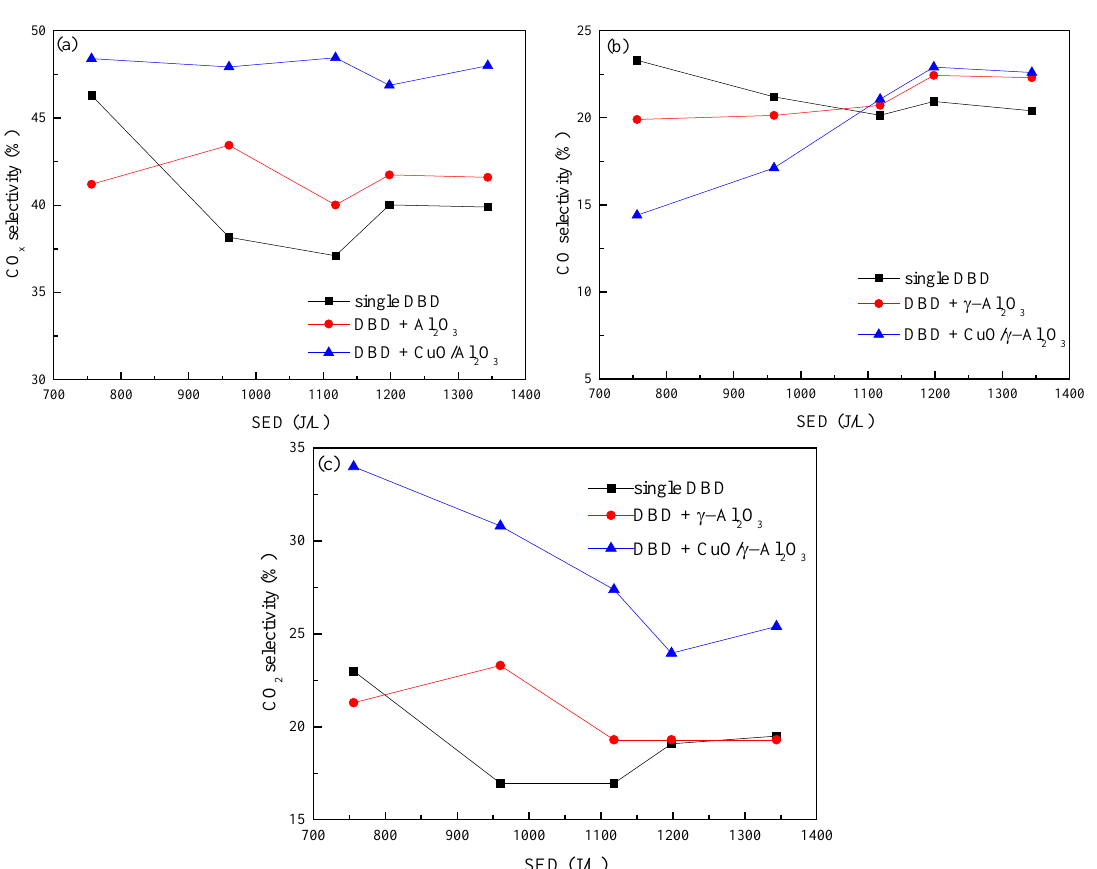
Figure 6. CO x ( a ), CO ( b ), and CO 2 ( c ) selectivity of chlorobenzene with catalyst loadings and absence of catalyst as a function of SED (flow rate = 3 L/min).